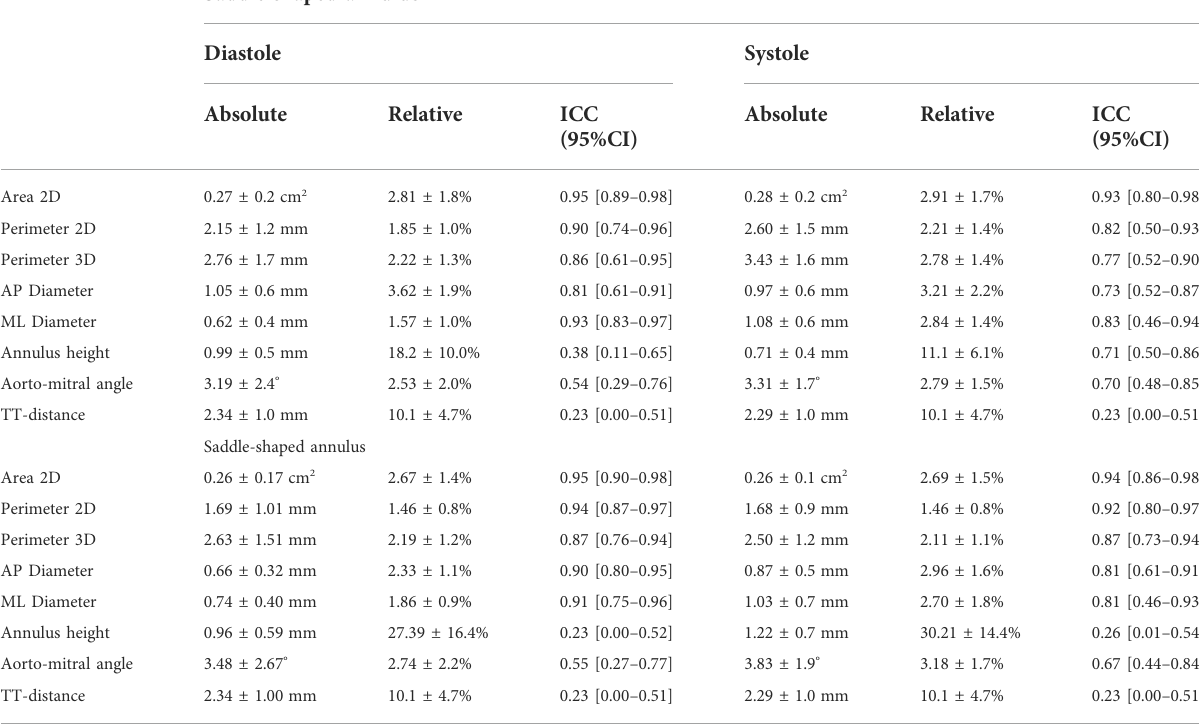
TABLE 2 Inter-observer variability for mitral valve